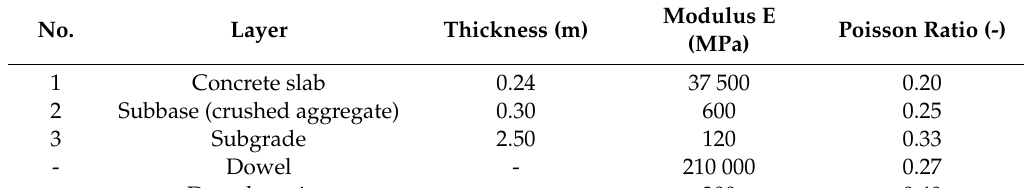
Table 1. Material parameters and thickness of concrete pavement.